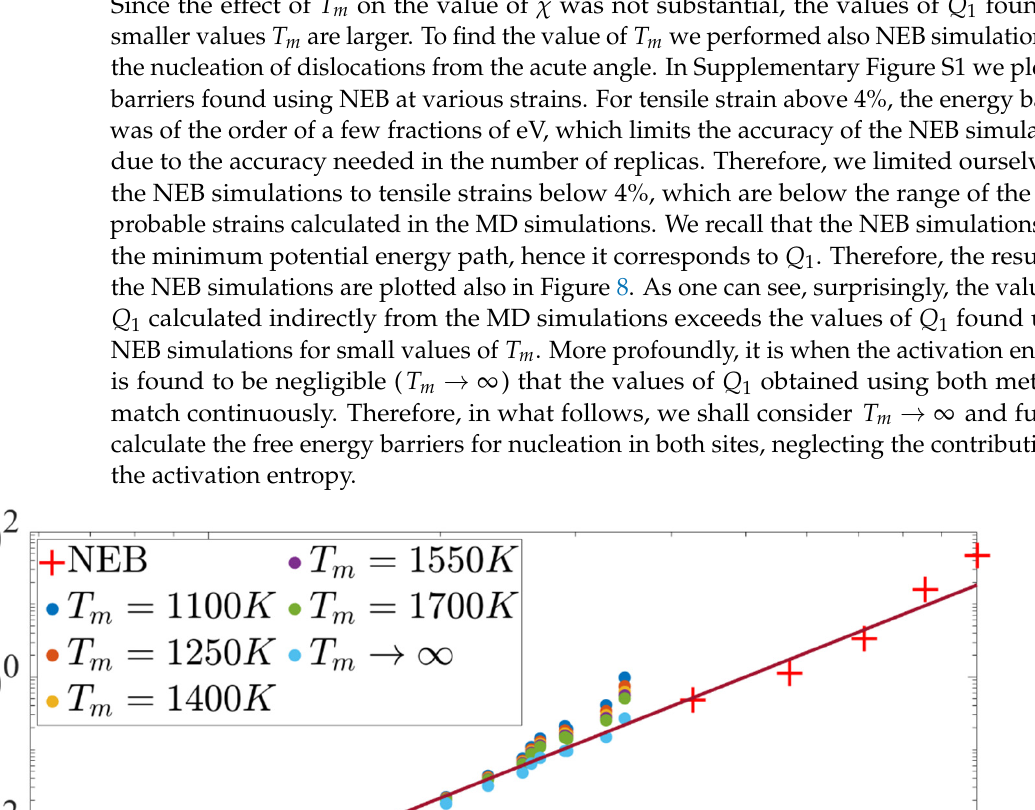
Figure 8. Temperature-independent part of the free energy barrier Q 1 as a function of ( 1 − ε / ε cr